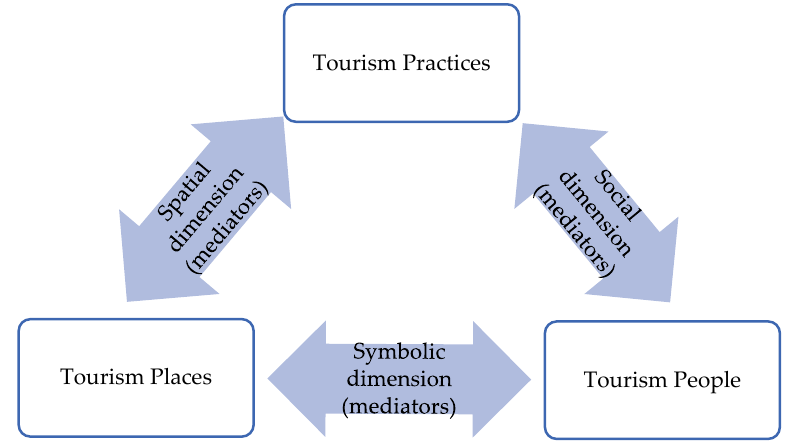
Figure 11. “Tourist landscape”: components, dimensions, and